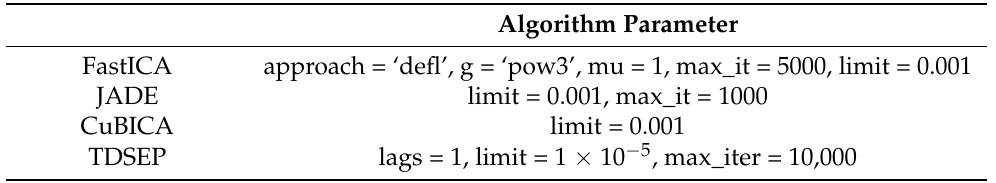
Table 7. Parameter setting of contrast algorithm.